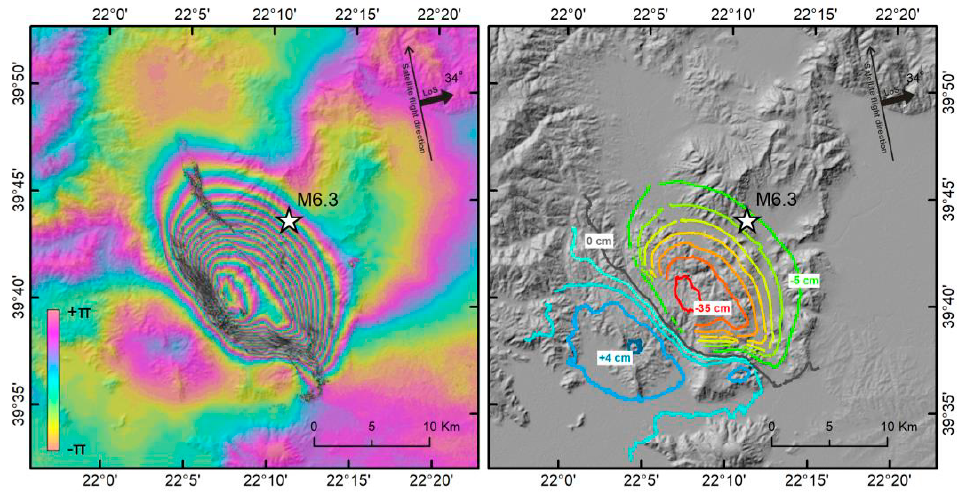
Figure 13. Co-seismic differential interferogram of the first main event (March 3) using Sentinel-1 pre- (25 February 2021) and post-event (3 March 2021) scenes acquired along the ascending 102 orbit ( left ) and extracted displacement contours after phase unwrapping ( right ). The reference point is located outside the shown frame. The maximum displacement calculated is 35 cm on the subsiding hanging wall of the seismic fault